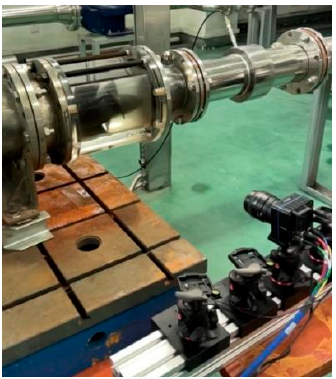
Figure 7. Cavitation visualization experiment.